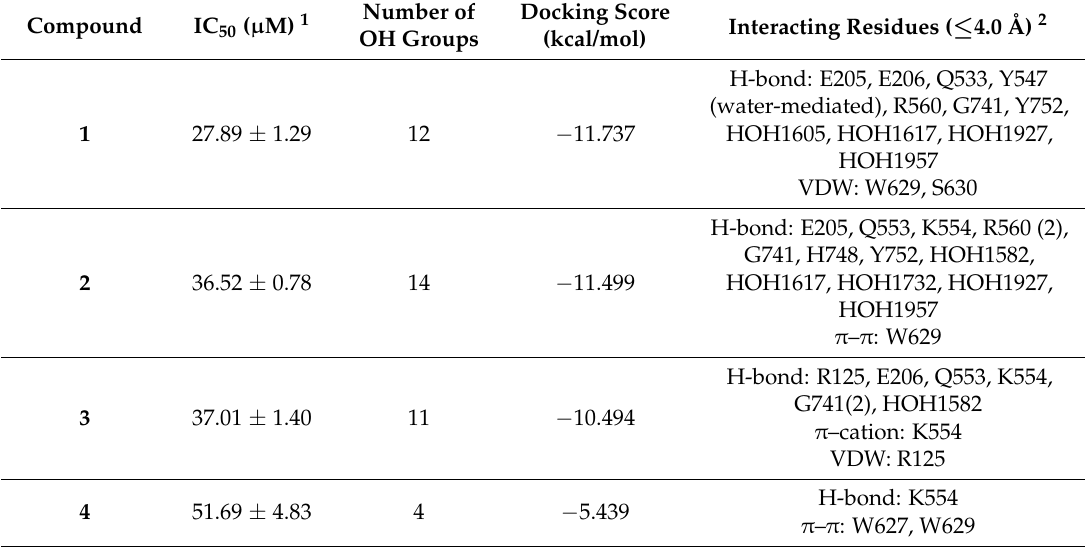
Table 1. Dipeptidyl peptidase IV inhibition by compounds 1 – 4 , as well as their docking energy and interaction